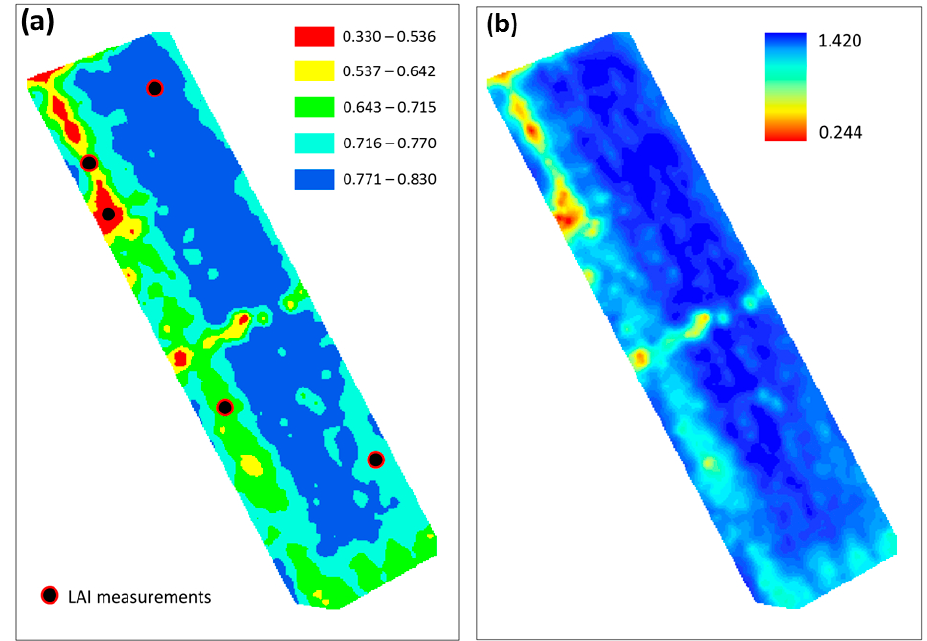
Figure 4. NDVI map of the vineyard ( a ), with pixels clustered in five classes as shown by the legend and indications on where PocketLAI estimates were collected, and the corresponding LAIv map ( b ) derived from the relationship between NDVI and PocketLAI measurements in the five points representative of each NDVI class.